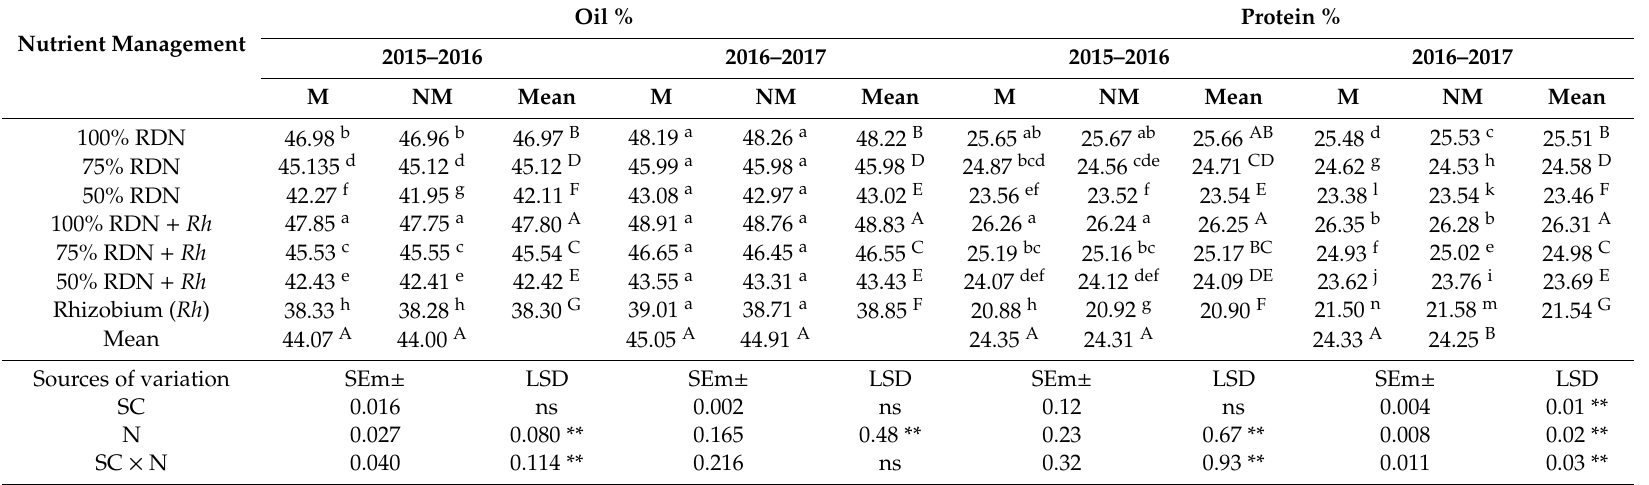
Table 6. E ff ect of soil covering and nutrient management on quality traits of peanut in 2015–2016 and